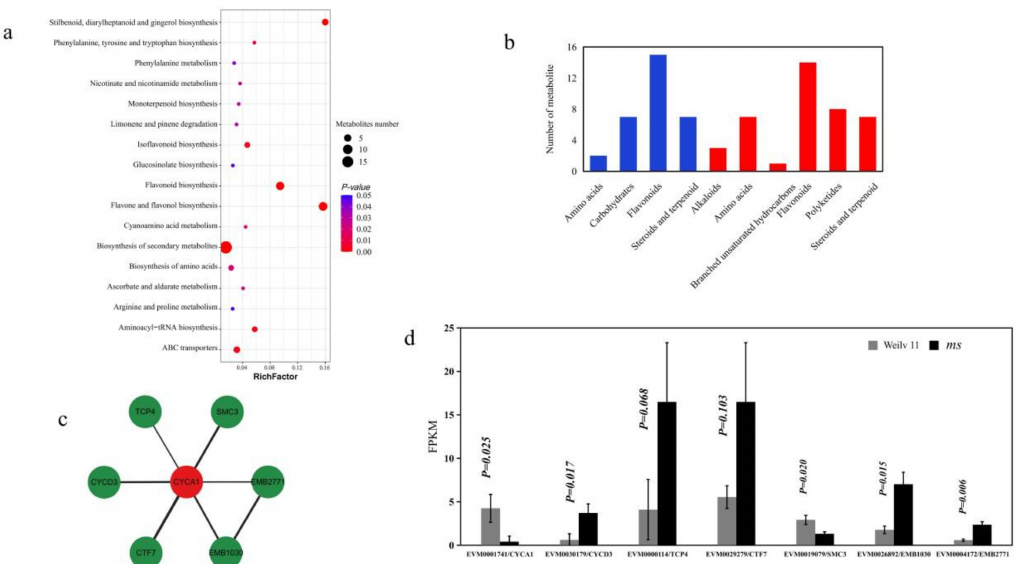
Figure 6. Pathway enrichment analysis corresponding to the differential metabolites. Statistical results of 165 significantly differentially concentrated metabolite pathway enrichment analysis. ( a ) The ordinate represents the metabolic pathway, and the abscissa represents the number of metabolites. The coloring indicates the p -value, with a higher value in blue and a lower value in red; a lower p -value indicates a more significant enrichment. The point size indicates the number of differential metabolites. ( b ) The classification of significantly regulated metabolites; the blue columns represent significantly downregulated metabolites, and the red columns represent significantly upregulated metabolites. ( c ) The protein–protein interaction between VrCYCA1 and six seed development-related genes. ( d ) Statistical analysis of the seven genes’ expression levels in Figure 6c; the t -test was used to test the significant differences in gene expression (fpkm) between CK (Weilyu 11) and ms